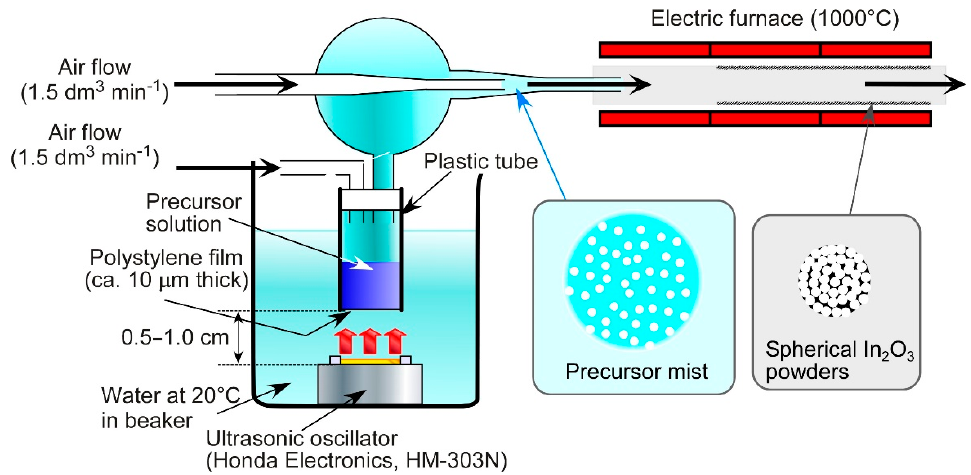
Figure 1. Schematic drawing of an apparatus of ultrasonic spray pyrolysis.